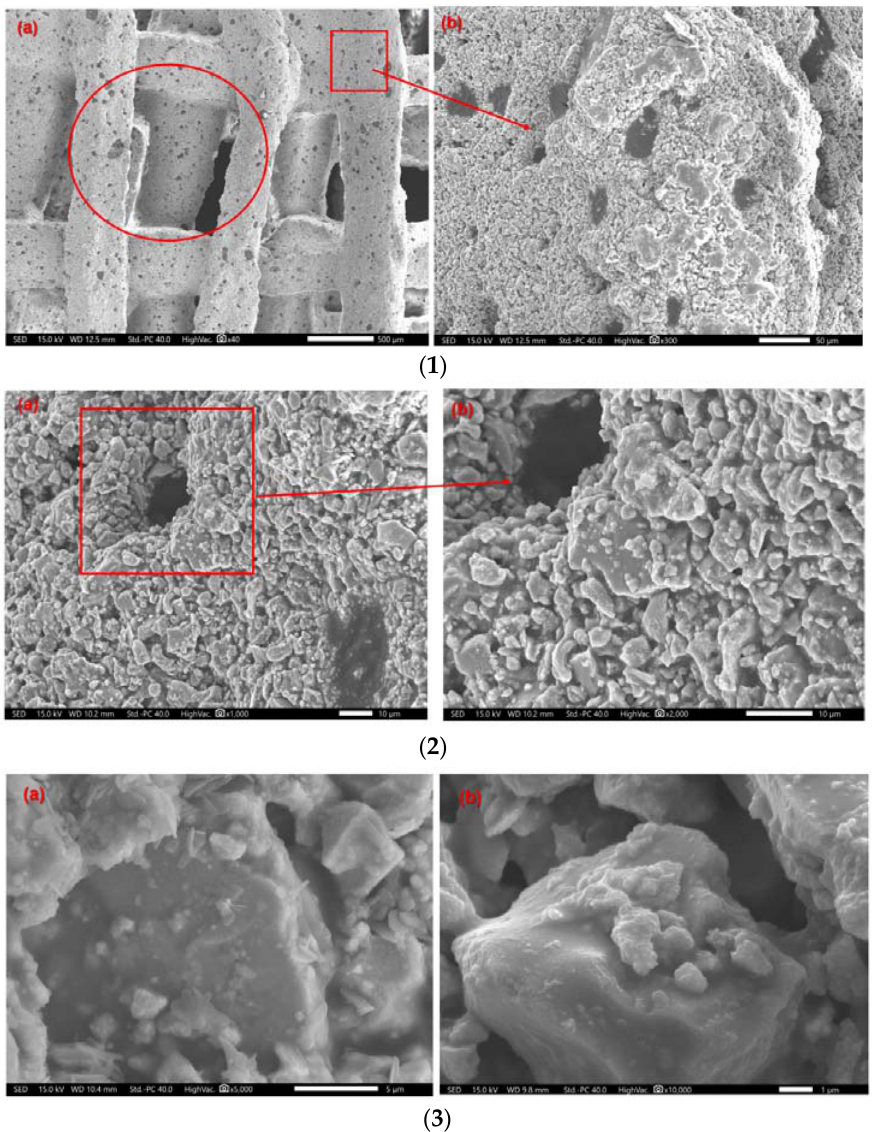
Figure 14. SEM of porous structure of composite scaffolds: ( 1 ) Scaffold unit and pore distribution; ( 2 ) Pore structure magnification 1000 × HA and zirconia distribution maps; ( 3 ) Pore structure internal details: ( a ) SEM result after a magnification of 5000 × g ; ( b ) SEM result after a magnification of 10,000 × g